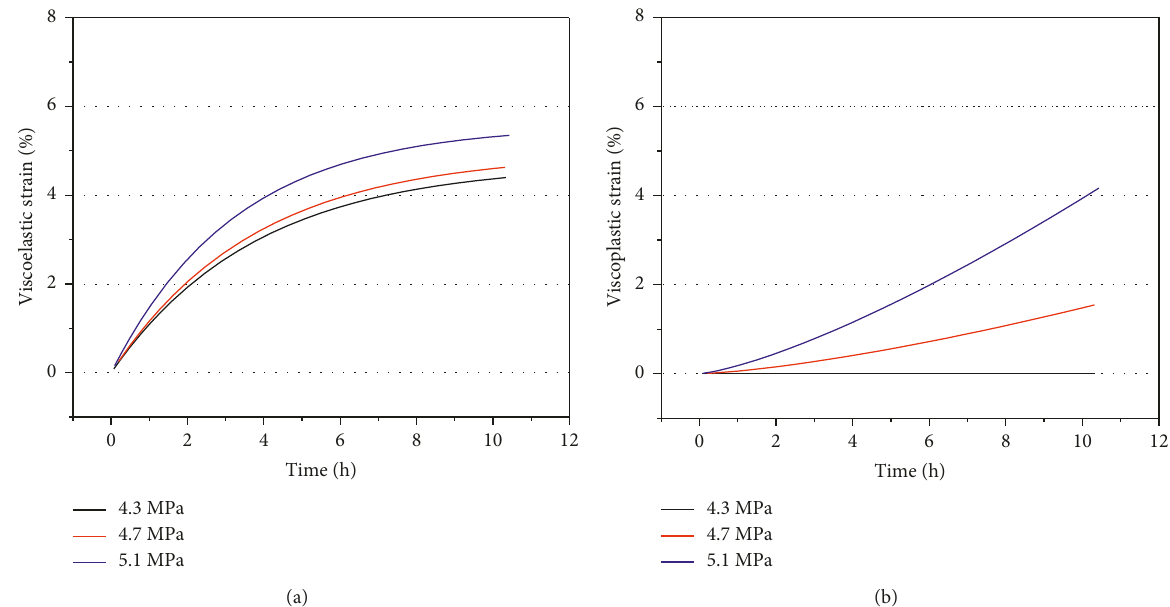
� 10MPa): (a) E 1 1 , (b) η 1 , (c) η 2 , and (d) e .